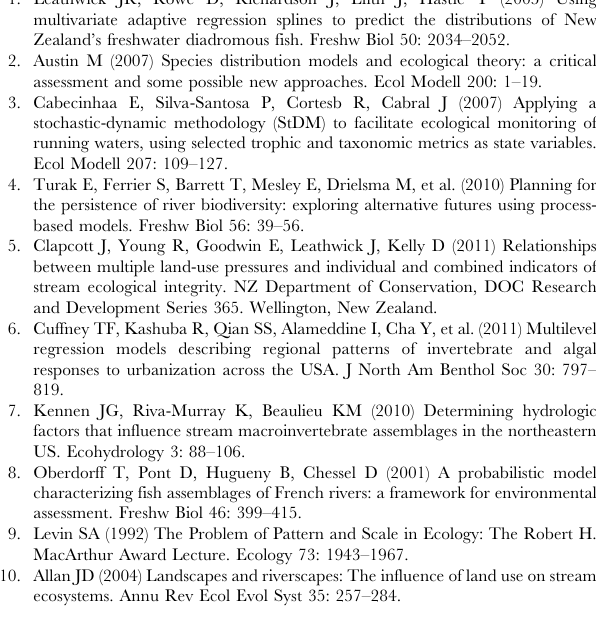
variable is reported in parentheses. Refer to Table 1 for variable definitions. Figure S2 Observed versus predicted plots for BRT models for development (left) and validation (right) data sets for the other three invertebrate metrics. The observed versus predicted plots are based on individual boosted regression models developed separately for three invertebrate metrics for all five models: Full Region and four individual ecoregions (NC Appalachian, Ridge and Valley, NE Highlands, and N.